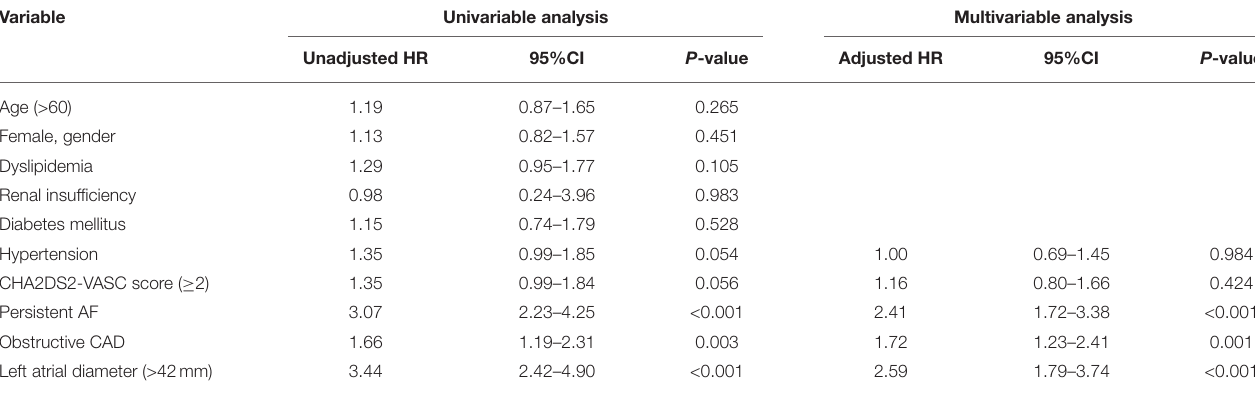
TABLE 2 | Univariable and multivariable regression analyses of the recurrence of atrial fibrillation between the patients with obstructive CAD and without obstructive CAD. Variable